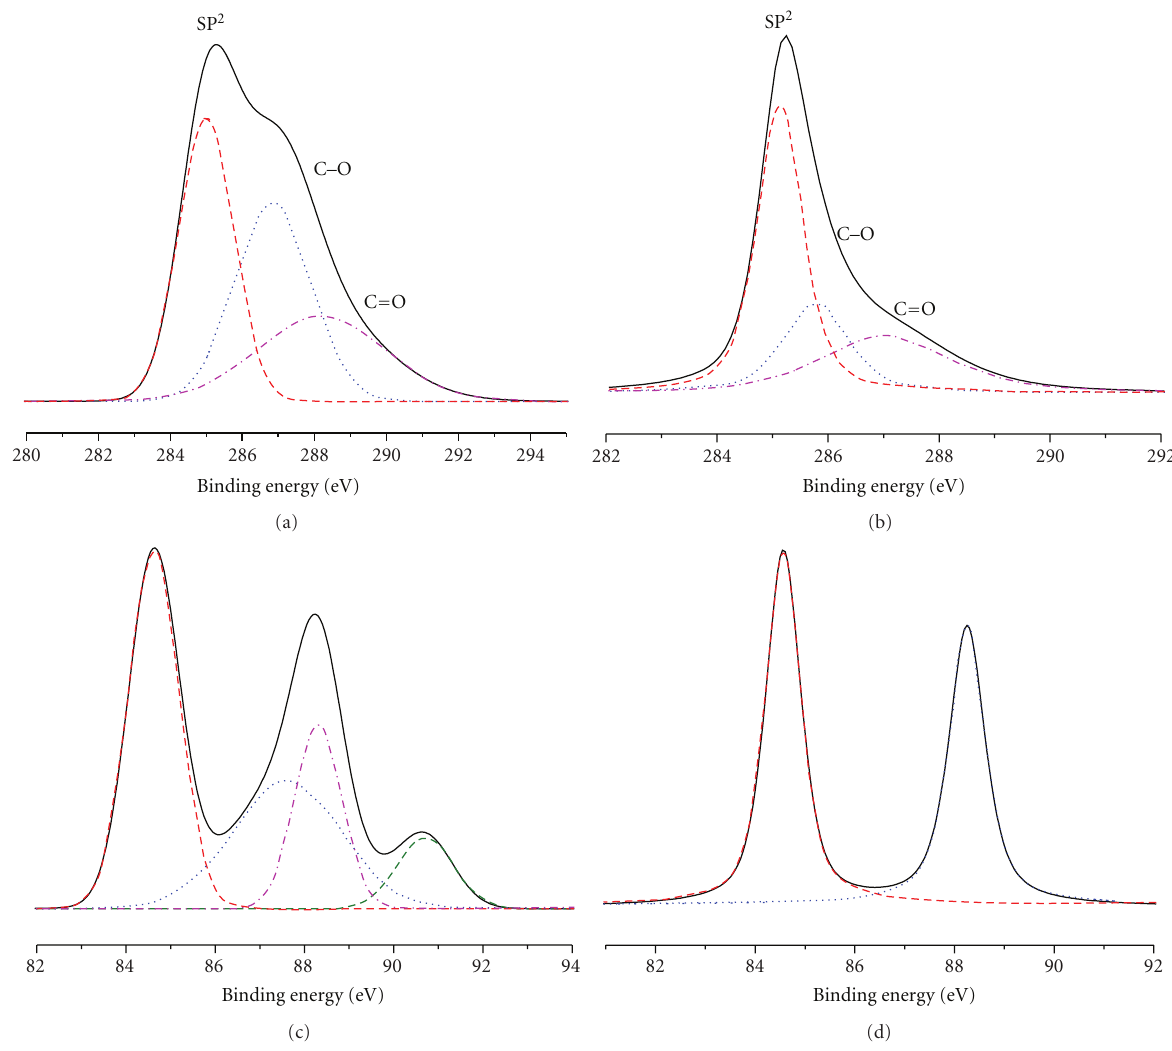
Figure 3: C1s XPS spectra of GO (a) and RGO-Au (b). The black solid lines are original spectra; the dash line, dot line and dash, and dot line are assigned to sp 2 -C, C–O (hydroxyl and epoxy groups), C = O (carboxyl groups), respectively. Au4f XPS spectra for the GO-AuCl 4 − and RGO-Au nanocomposites: (c) GO-AuCl 4 − and (d) RGO-Au.